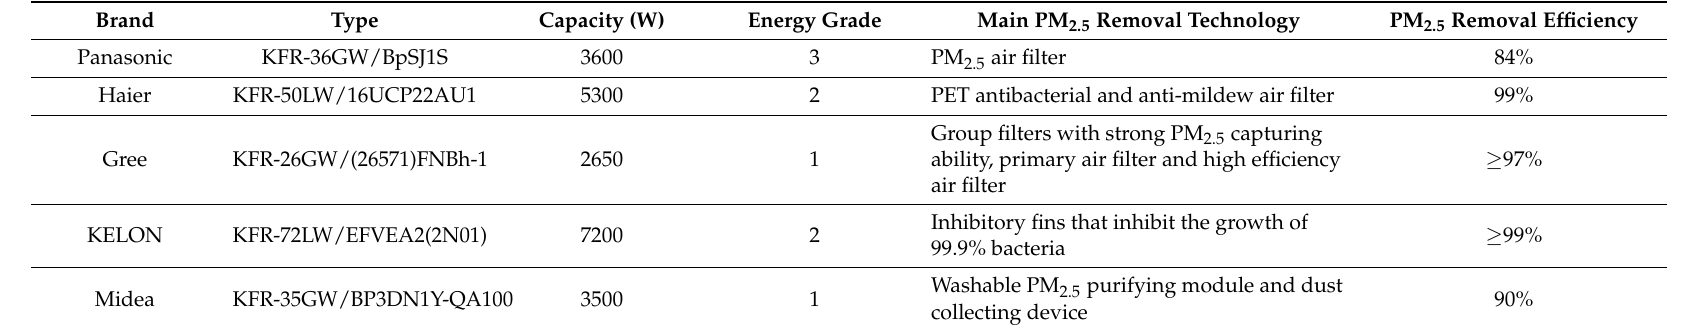
Table 5. Air conditioner with efficient PM 2.5 purification